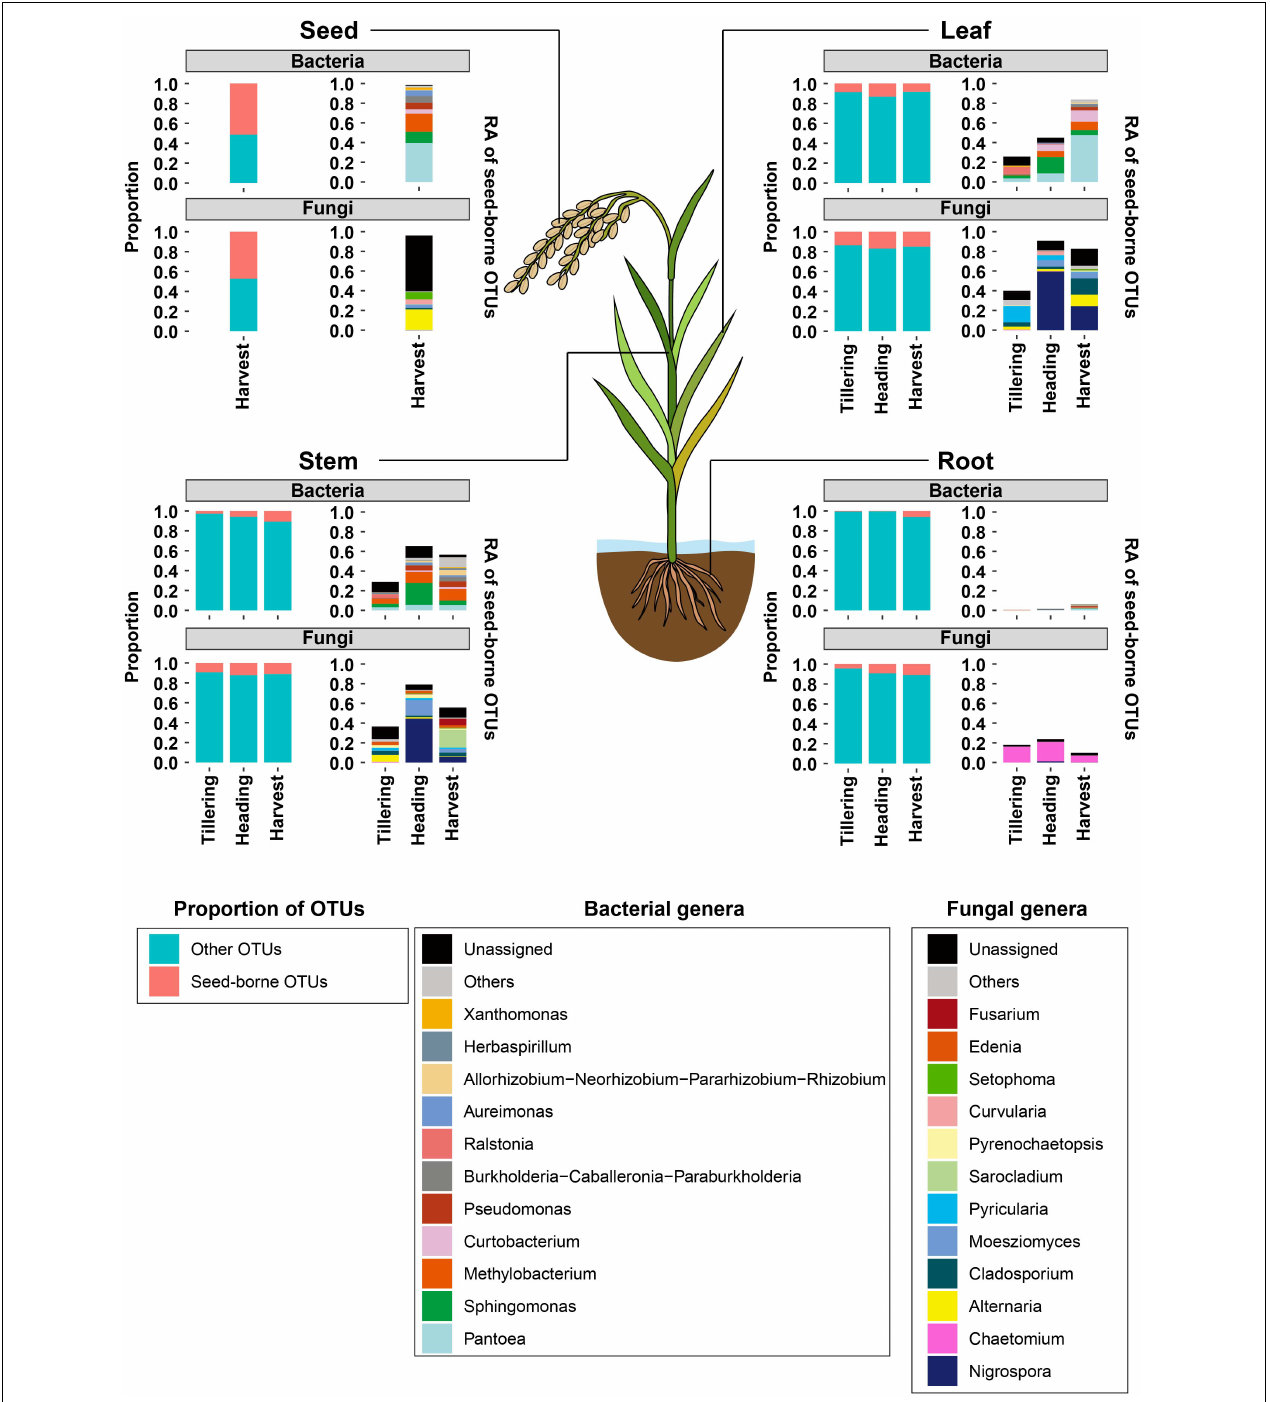
FIGURE 5 | Distribution of seed-borne bacterial and fungal communities in compartments of field-grown rice plants. The distributions of seed-borne bacterial and fungal OTUs were investigated at three developmental stages: tillering, heading, and harvest. At each developmental stage, the proportion of seed-borne OTUs in the leaf, stem, root, and seed endospheres was calculated as the number of seed-borne OTUs divided by the total numbers of OTUs in that compartment. The proportions of seed-borne OTUs are indicated with magenta-colored bars. The remaining portions are indicated with cyan-colored bars. Taxonomic composition of seed-borne OTUs in plant compartments is shown at the genus level. Each color on the bar plots represents a bacterial or fungal genus. Genera with relative abundance lower than 0.03 are grouped into “Others.” The raw data on the relative abundances of bacterial and fungal genera are available in Supplementary Table 6 . RA, relative